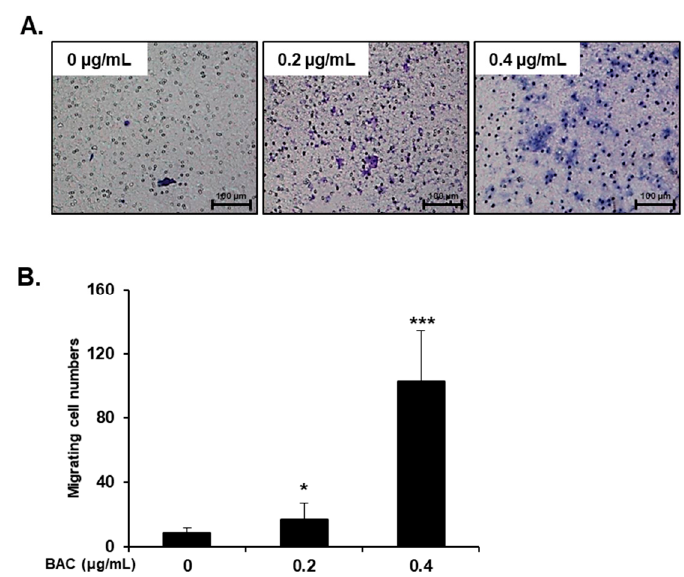
Figure 8. Increased cell migration by BAC treatment. H358 cells were treated with BAC for 21 days and ( A ) cell migration assay was performed for 16 h using a transwell chamber on day 22. ( B ) Migrated cells were counted and plotted as mean ± SD. Statistical significance was determined by Student’s t-test (* p < 0.05, *** p < 0.001, compared to untreated cells). Scale bar, 100 μ m.